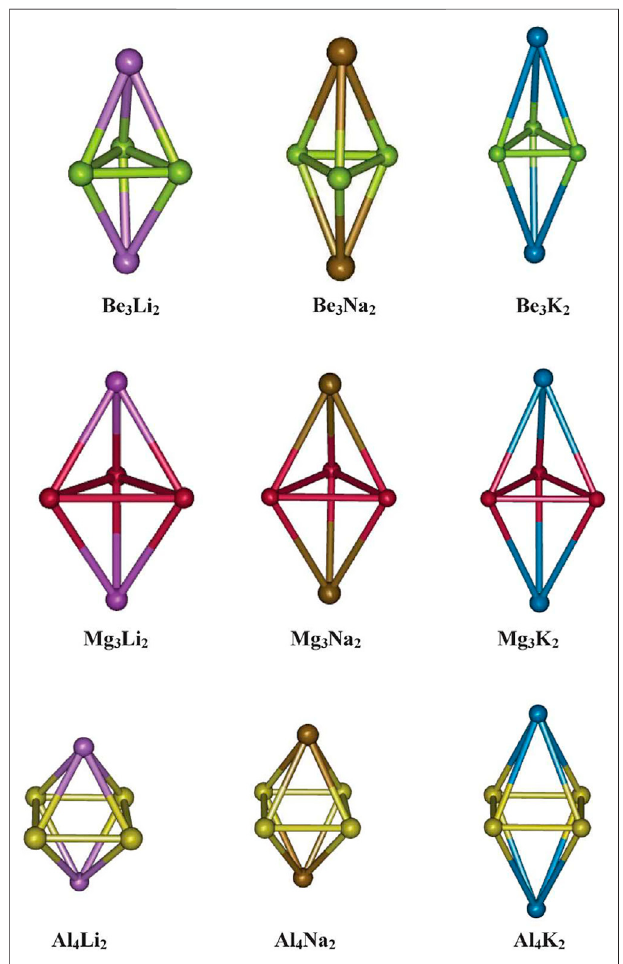
FIGURE 2 | Optimized geometries ofBe 3 M 2 , Mg 3 M 2 , and Al 4 M 2 (M (cid:1) Li, Na, and K) (Reproduced from Srinivasu et al., 2012 with permission from the Royal Society of